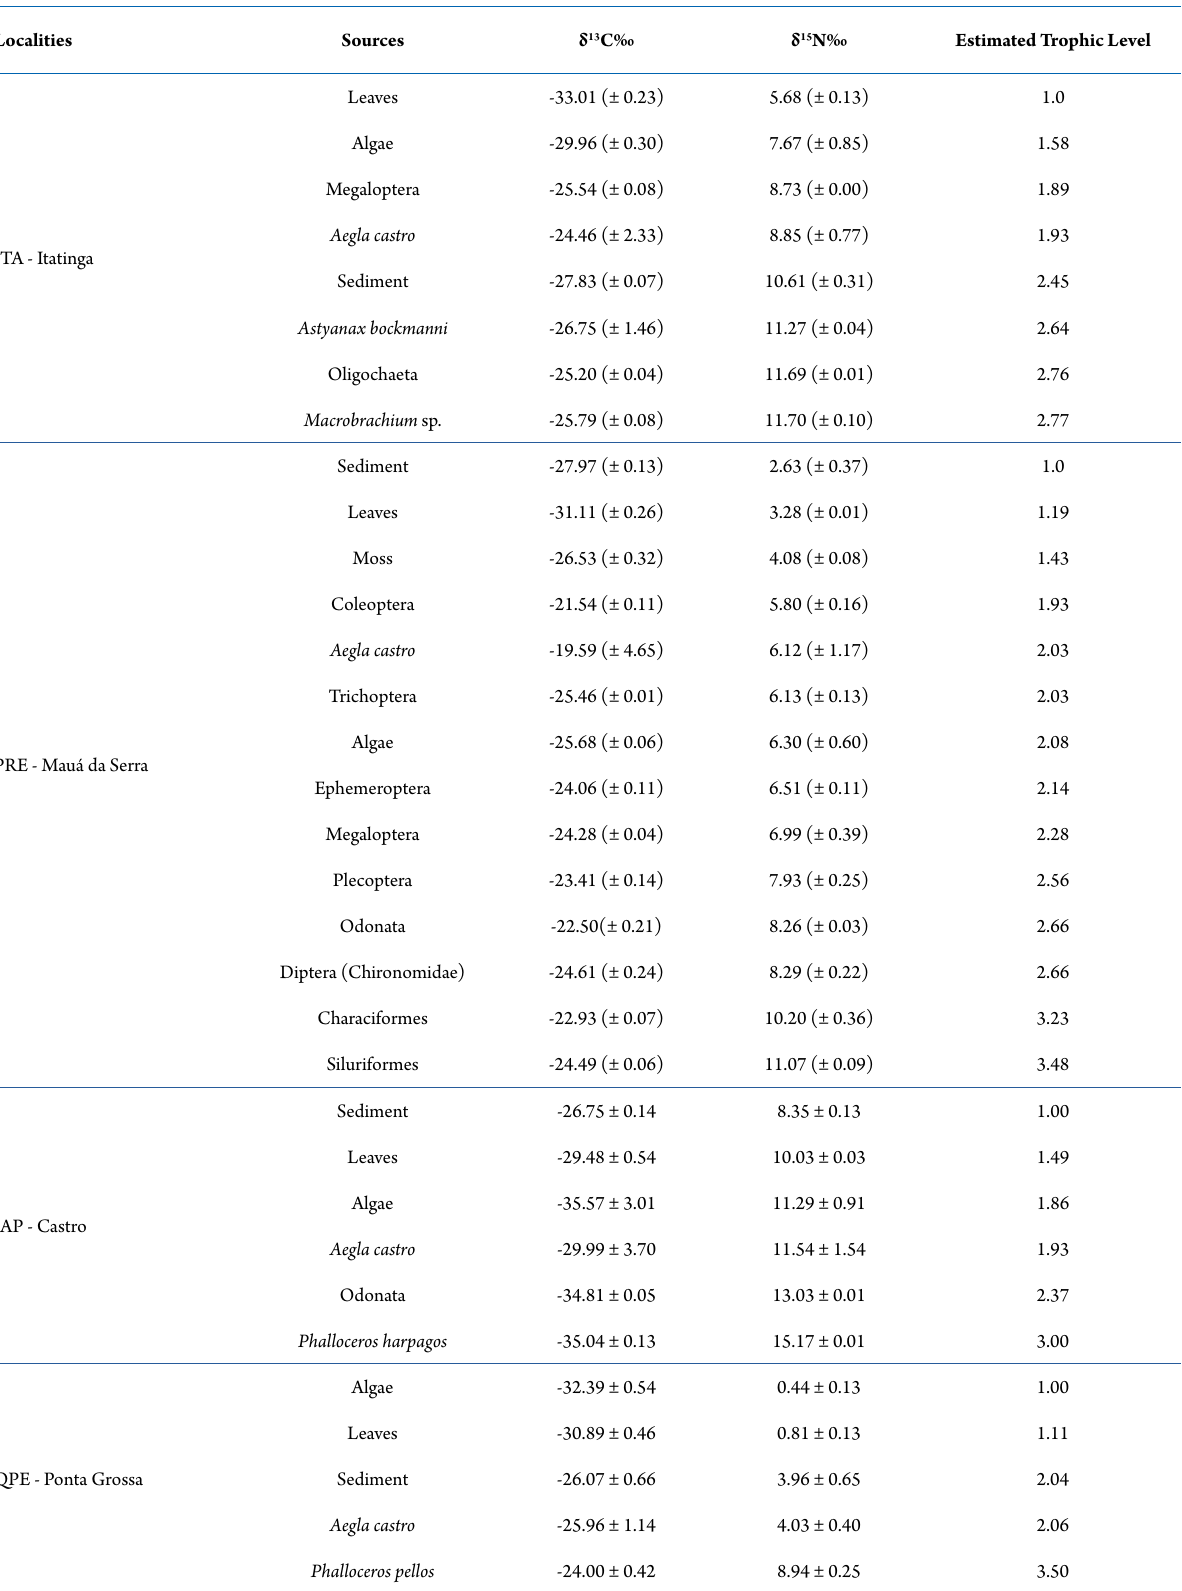
Table 3. Stable isotope signatures for carbon and nitrogen (mean ± SD) and the estimated trophic level of the organisms, in the freshwater community trophic web with Aegla castro at ITA (São Paulo State) and PRE, IAP and QPE (Paraná State), Brazil. ITA: Itaúna stream, PRE: Preto stream, IAP: Iapó stream, QPE: Quebra Perna